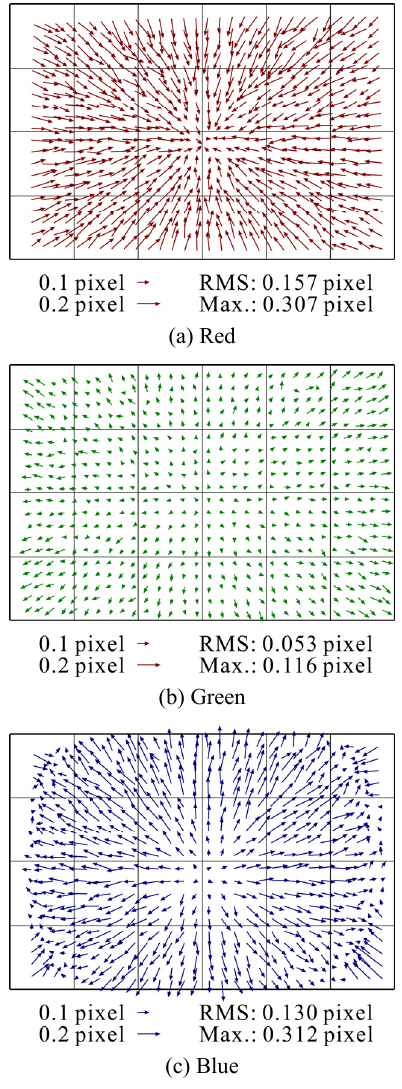
Figure 9. Displacement vectors caused by lossy JPEG compression with 1x1 1x1 1x1 sampling